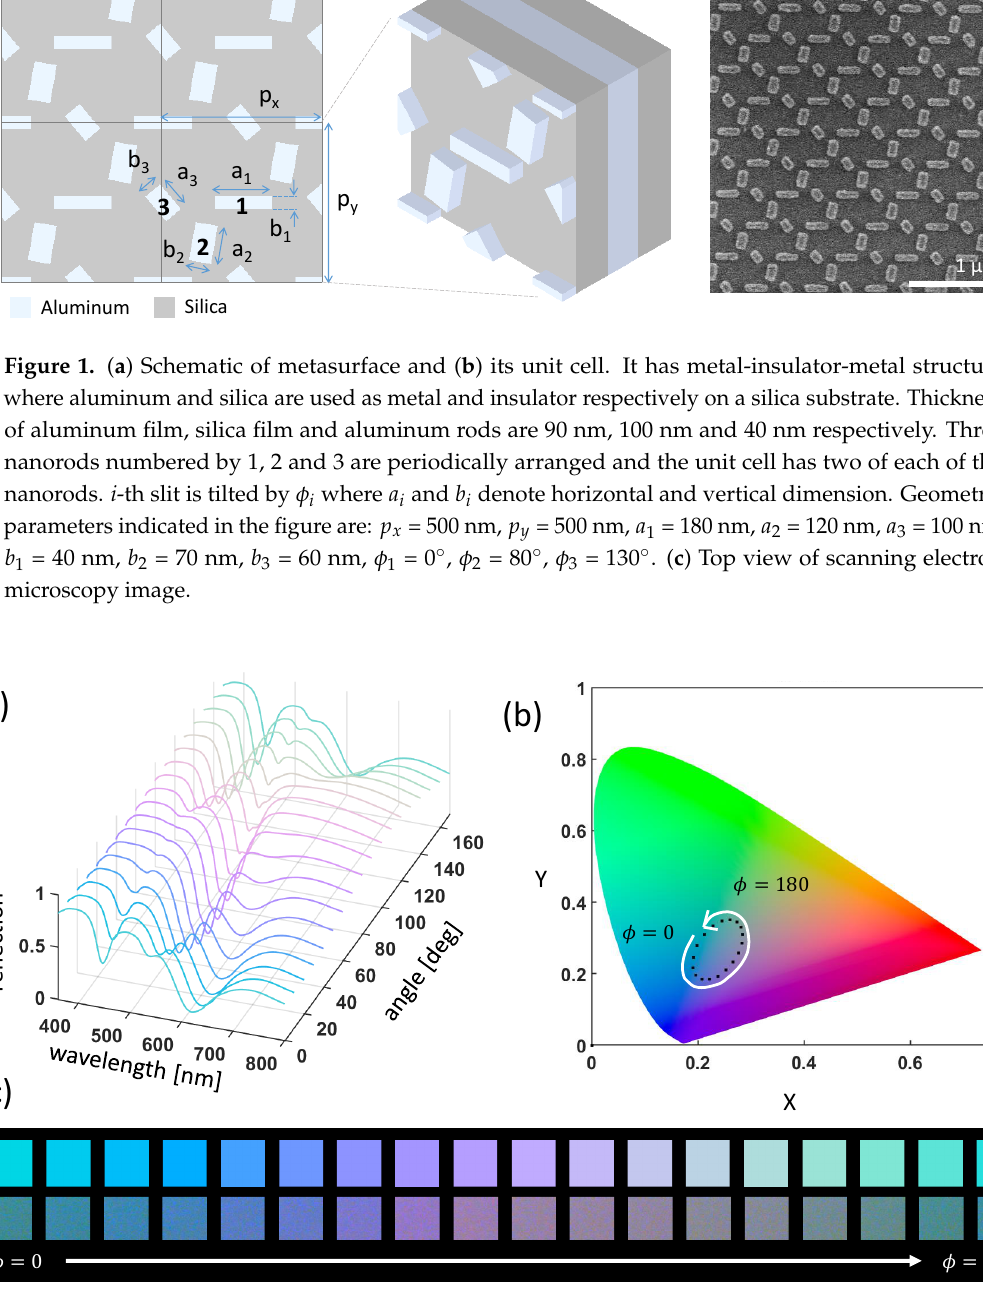
Figure 2. ( a ) Polarization dependent reflection spectrum, ( b ) CIE 1931 chromaticity diagram and ( c ) color palette. Simulated and experimentally obtained colors are shown in the first and second rows respectively. Polarization angle of incidence is represented in